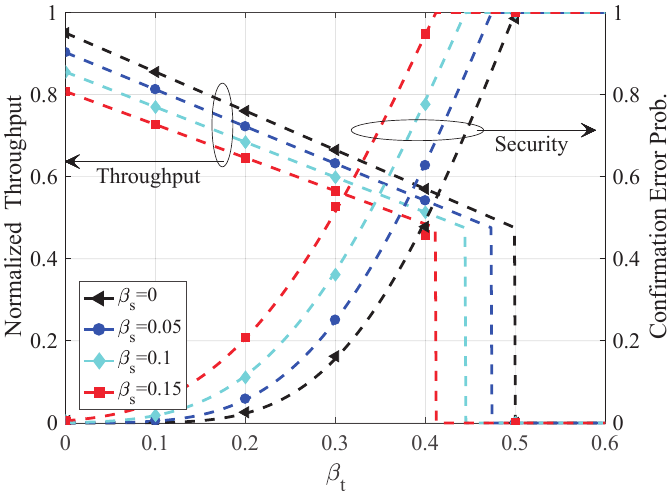
Figure 4. Analytical and simulation results of throughput and safety property of the proposed